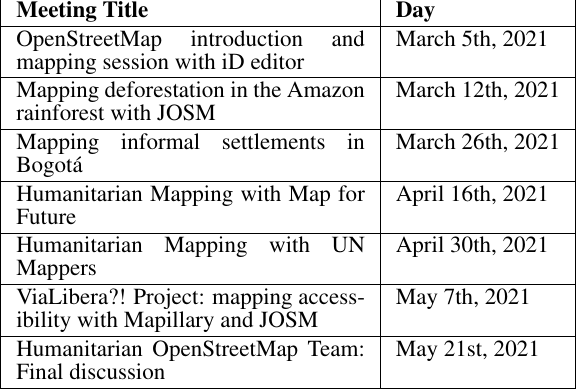
Table 1. Summary of the course lessons and calendar quality assurance tool, giving feedback and suggestions to the students with comments on their changesets.